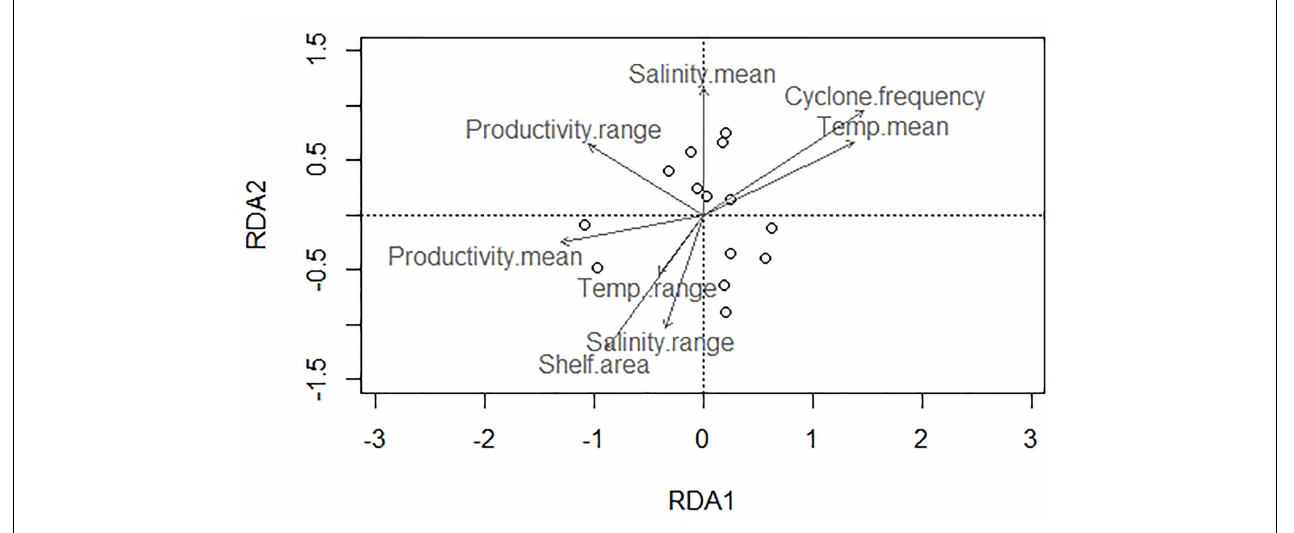
FIGURE 7 | Redundancy analysis (RDA) biplot of bivalve species composition and environmental parameters.